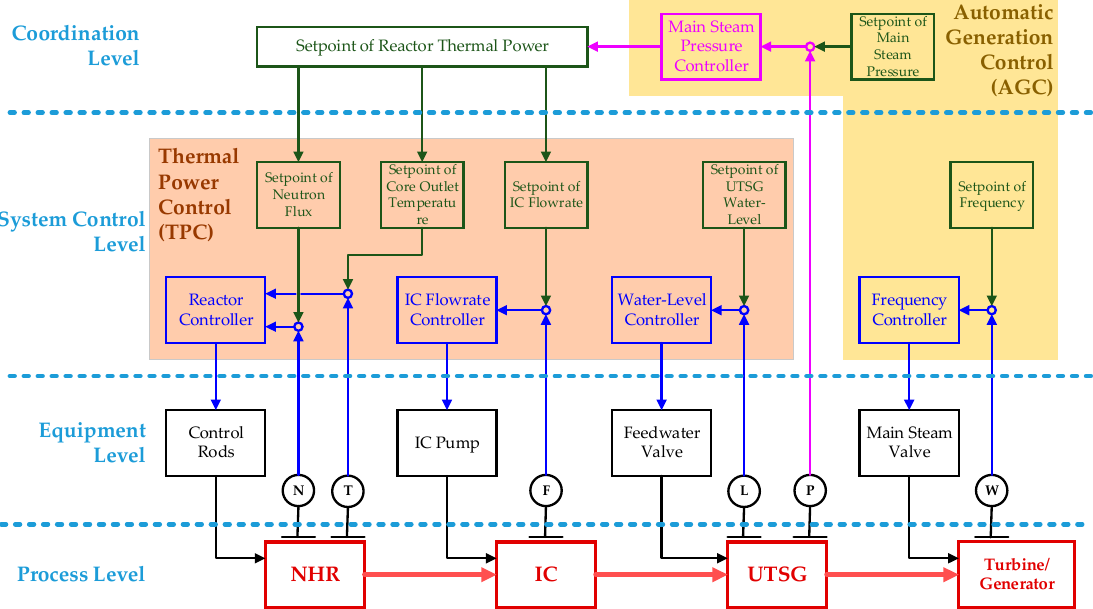
Figure 3. Control scheme diagram of nuclear heating reactor (NHR) power plant.